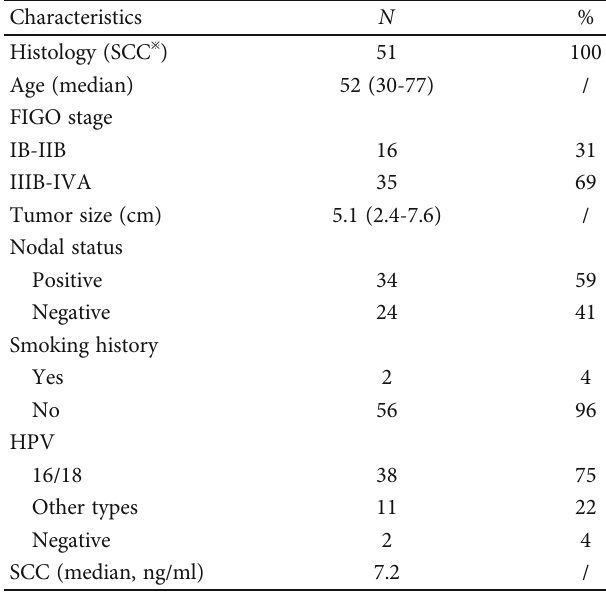
Table 1: Baseline characteristics of 51 LACC patients.